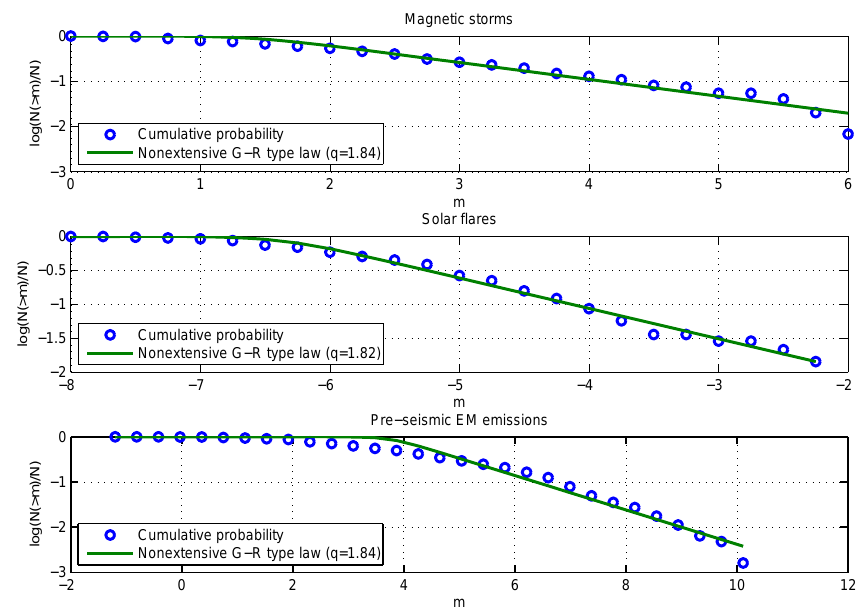
Fig. 3. We use the Gutenberg-Richter (G-R) type law for the nonextensive Tsallis statistics (Eq. 10) to calculate the relative cumulative number of D st data, N(>m)/N (upper panel). There is an excellent agreement of the aforementioned formula with the D st time series. The threshold is − 30nT, which results in 164 events, and the associated parameter is q = 1.84. We then use Eq. (10) to calculate the relative cumulative number of X-ray flux data, N(> m)/N (middle panel). There is an excellent agreement of the aforementioned formula with the X-ray flux time series. The threshold is 10 − 6 Wm − 2 , which results in 141 events, and the associated parameter is q = 1 . 82. Finally, Eq. (10) is used to calculate the relative cumulative number of pre-seismic EM emission data, N(> m)/N (lower panel). There is an excellent agreement of the aforementioned formula with the pre-seismic EM emission time series. The threshold is 500mV, which results in 626 events, and the associated parameter is q = 1 .